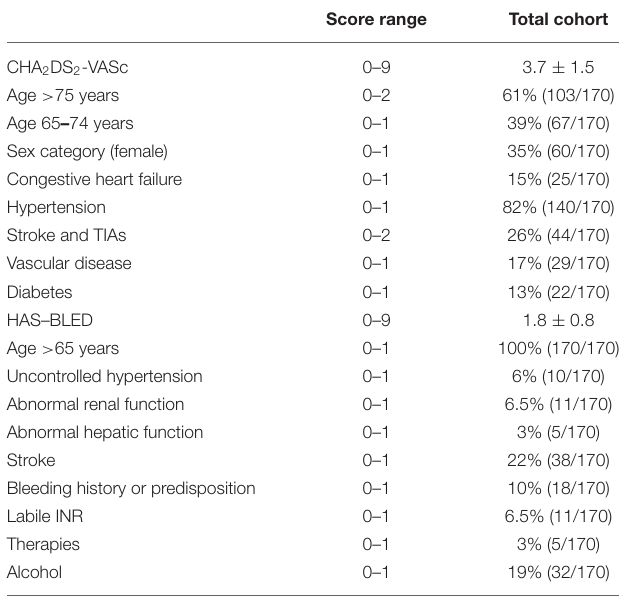
TABLE 1 | Demographic and clinical characteristics, cognitive, and motor performances; and depressive symptoms of the baseline Strat-AF study cohort ( n = 170).